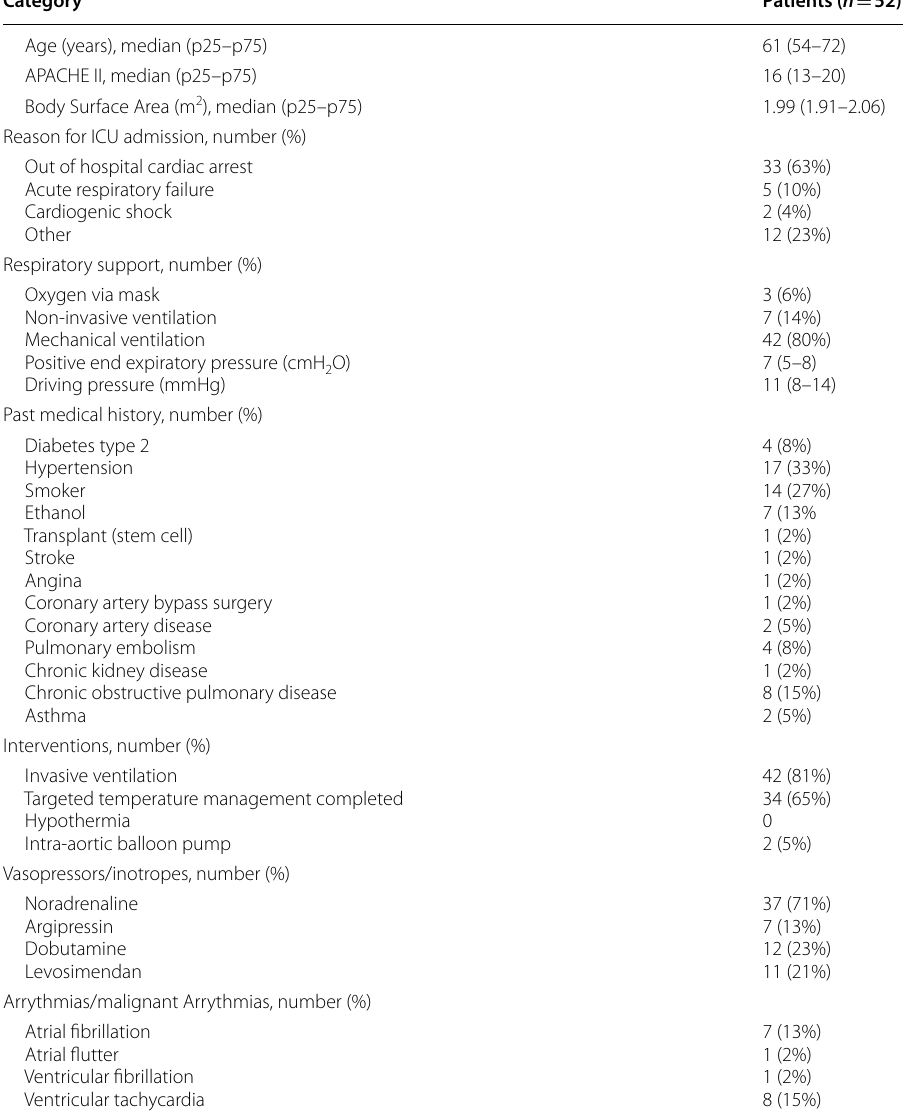
Table 1 Characterisation of